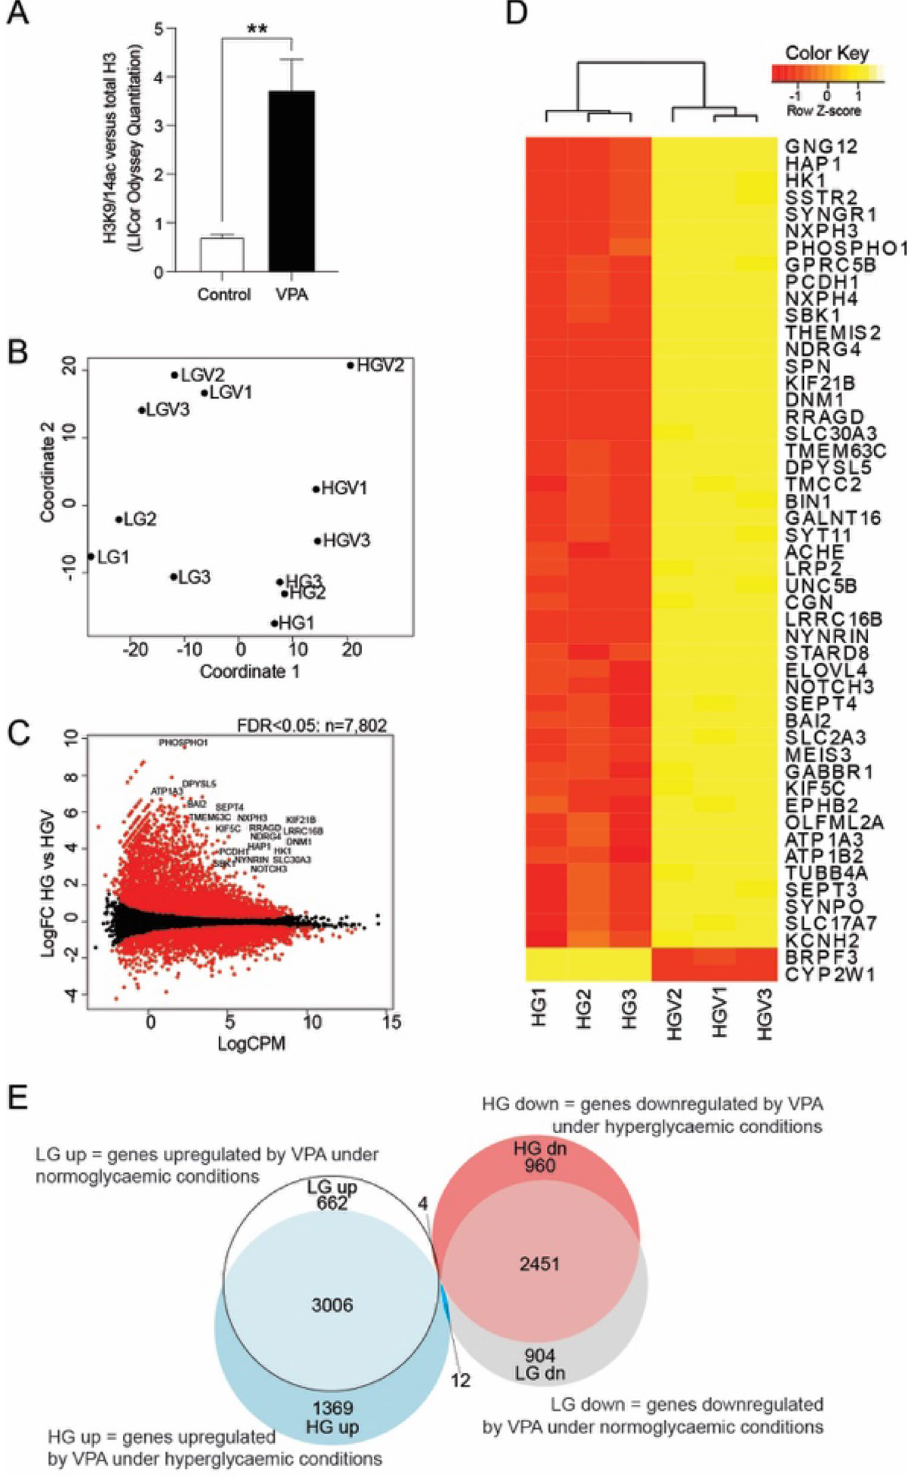
Figure 3. Effect of VPA stimulation on hyperglycaemic HepG2 gene expression. ( A ) VPA induces H3 acetylation in a time- dependent manner. Quantitative analysis of H3K9/14ac and unmodified histone H3 protein using LI-COR Odyssey imaging system. Normoglycaemic HepG2 cells treated with 1 mM VPA in comparison with untreated control. ( B ) Multidimensional scaling analysis shows samples cluster based upon treatment groups. ( C ) Smear plot showing the effect of VPA treatment on hyperglycaemic HepG2 cells. Genes with differential expression (FDR ≤ 0.05) are highlighted in red. ( D ) Heatmap of the 50 most significant differentially expressed genes responding to VPA. LG, low glucose—normoglycemic condition. LGV, normoglycemic condition followed by VPA treatment. HG, high glucose—hyperglycaemic condition. HGV, hyperglycaemic condition followed by VPA treatment. ( E ) Venn diagram showing gene expression changes regulated by VPA under normoglycaemic and hyperglycaemic